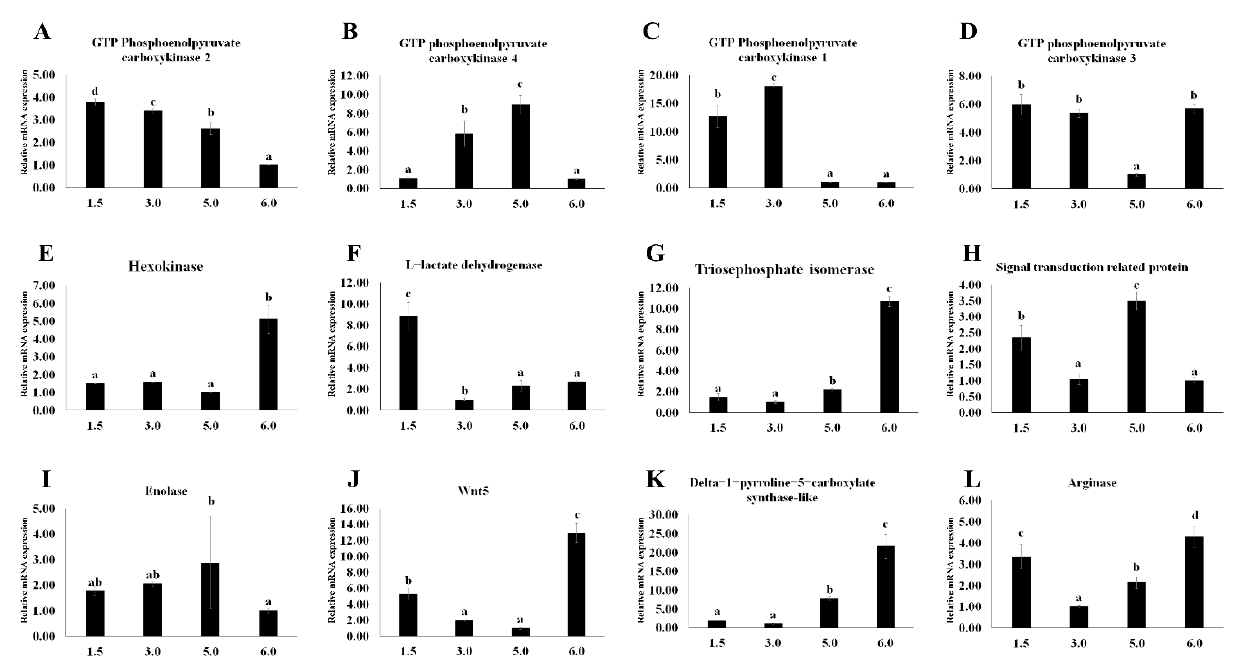
Figure 6. Expression of selected genes in different oxygen concentrations in Macrobrachium nipponense by qRT-PCR. ( A ): Mn-PEPCK2, ( B ): Mn-PEPCK4, ( C ): Mn-PEPCK1, ( D ): Mn-PEPCK3, ( E ) Mn-HK, ( F ) Mn-LDH, ( G ) Mn-TPI , ( H ) Mn-STP, ( I ) Mn-ENO, ( J ) Mn-Wnt5, ( K ) Mn-P5CS, ( L ) Mn-ARG. Data are shown as means ± SD of three replicates in various tissues. Statistical analyses are shown with one-way ANOVA. Different letters indicate a significant difference of the same gene in different tissues ( p < 0.05).